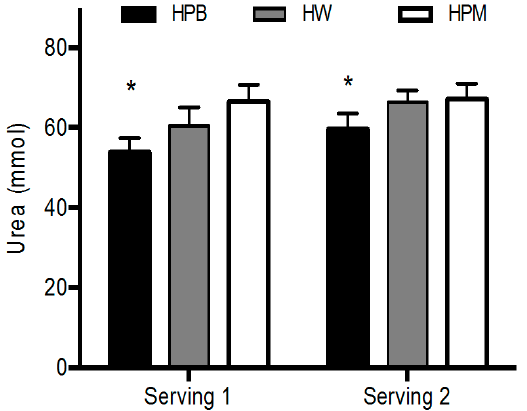
Figure 6. Mean ± SEM postprandial urea concentrations after serving 1 and serving 2, n = 18. * HPB significantly different from HPM and HW, p < 0.01. Data were analyzed using a linear mixed-effects model with a serving-treatment interaction and treatment order, age and as fixed effects and with subject-specific random effects. HPB, hydrolyzed porcine blood protein; HPM, hydrolyzed porcine muscle protein; HW, hydrolyzed whey protein